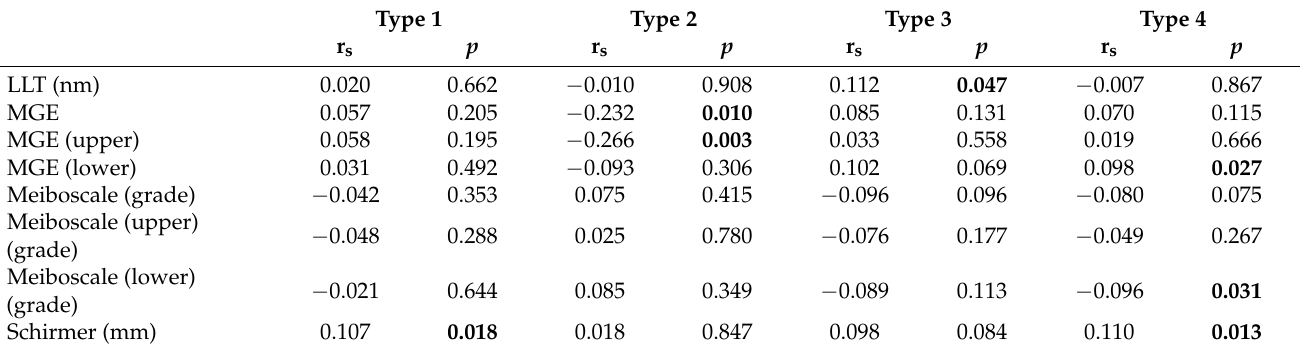
Table 6. Correlations between FTBUT and lipid/aqueous